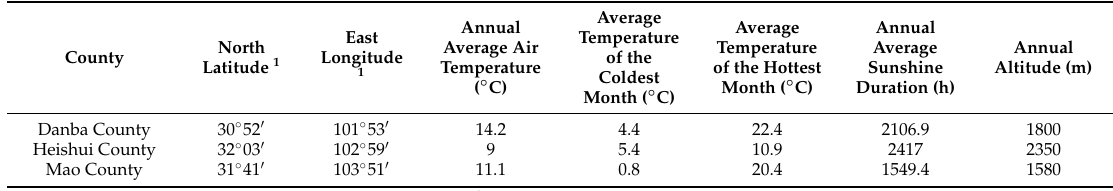
Figure 2. Building climate demarcation of Sichuan province. Table 1. Comparison of the meteorological parameters of typical county in cold rural area of